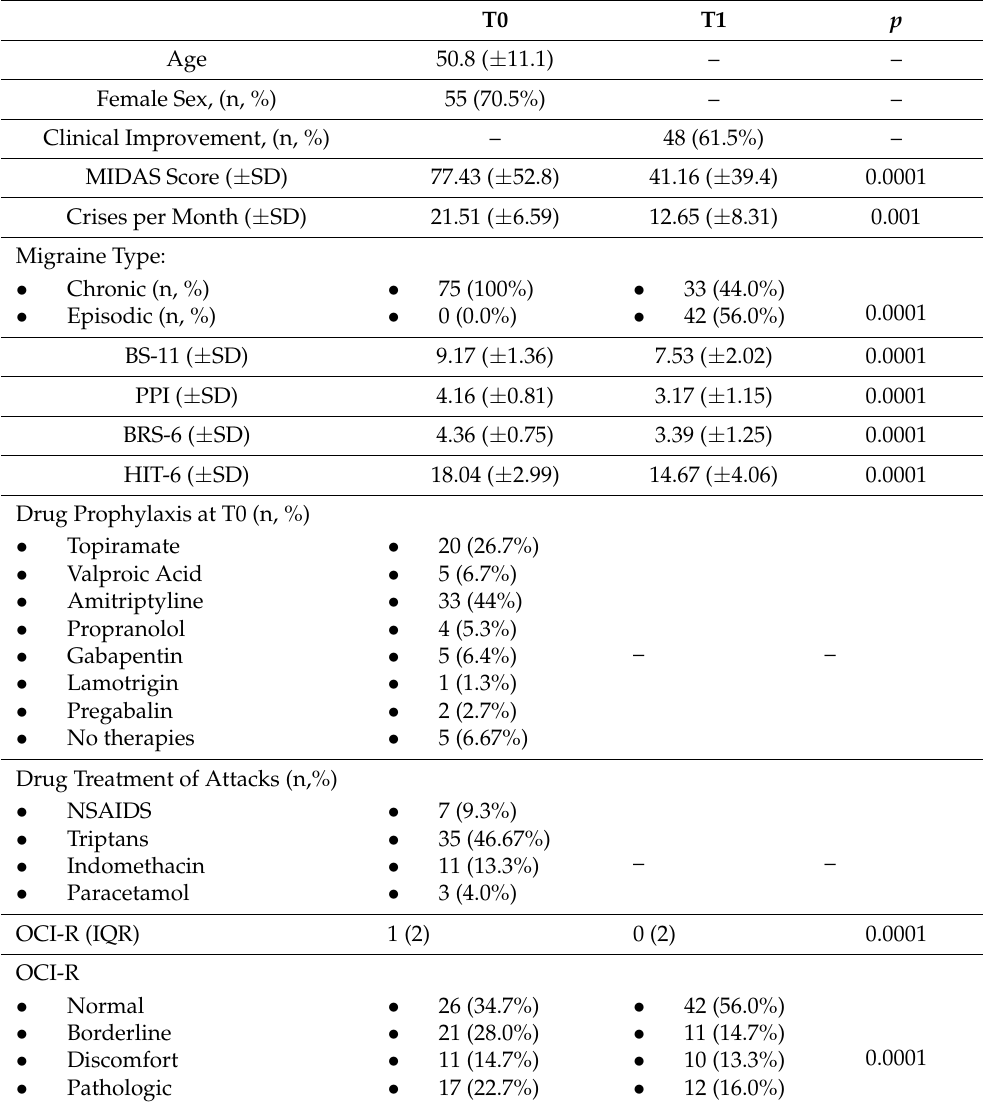
Table 1. Baseline characteristics of the cohort at T0 and T1.